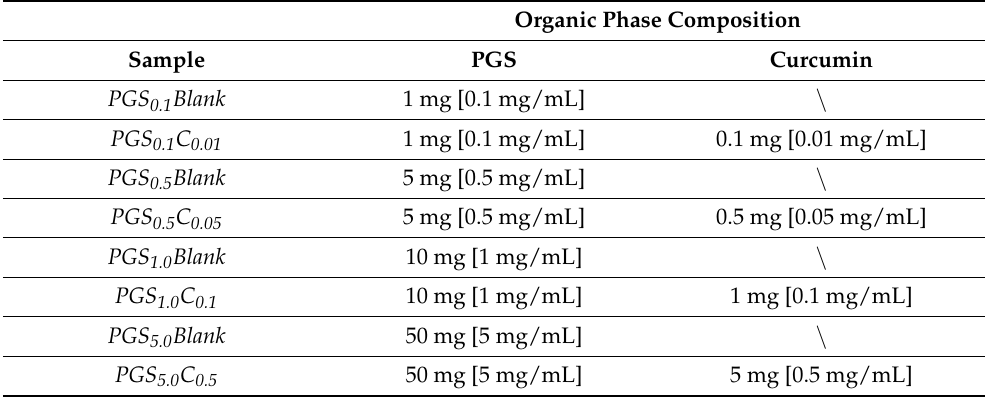
Table 3. Tested formulation parameters for the preparation of PGS-based NPs by nanoprecipitation. Organic Phase